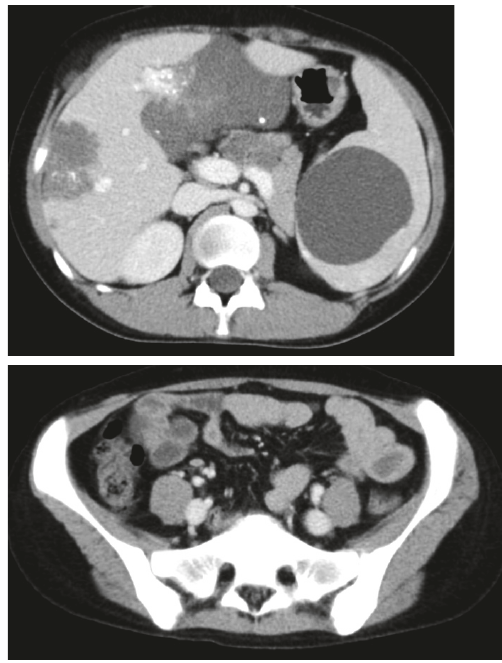
Figure3:Computedtomographyat19yearsofagerevealedmultiple VMs on almost the entire GI tract, liver, and